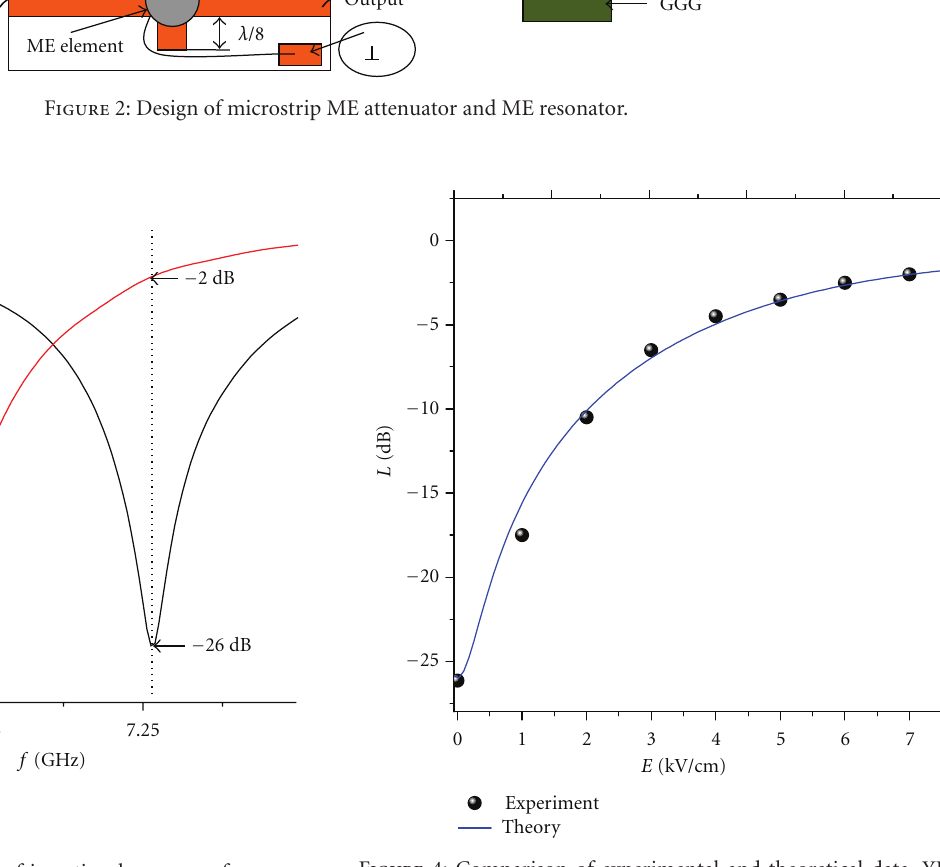
Figure 3: Experimental curves of insertion loss versus frequency. YIG [111] thickness is 110 μ m; diameter is 2,5 mm; PMN-PT thickness is 0,5 mm; diameter is 6mm; field H = 1910 Oe; field is parallel to plane of sample; central frequency is 7251 MHz.